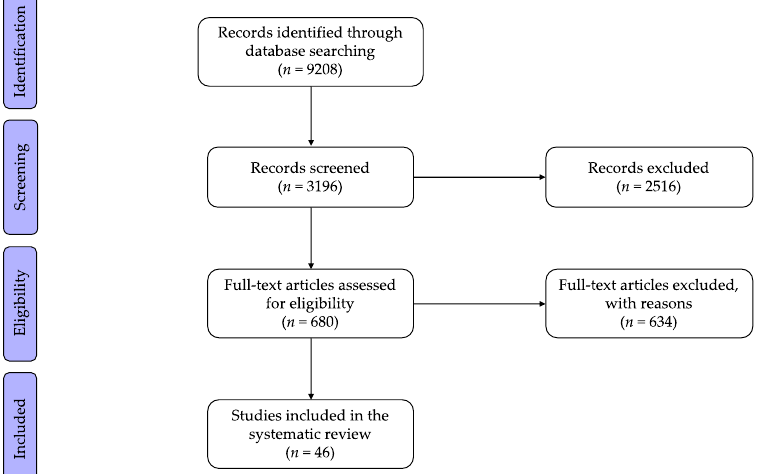
Figure 1. Preferred Reporting Items for Systematic Reviews and Meta-Analysis (PRISMA) flow diagram.